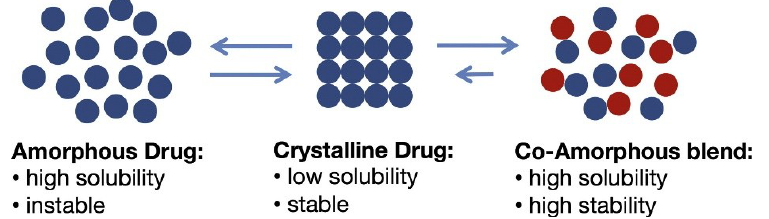
Figure 2. Advantages of co-amorphous dispersions over the corresponding amorphous and crystalline drugs [10].